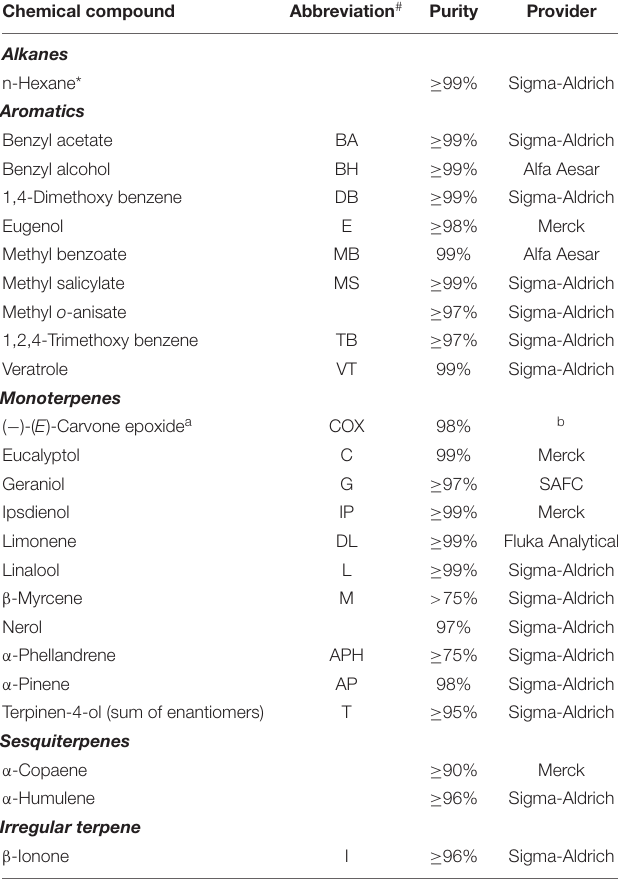
TABLE 2 | Tested compounds in the